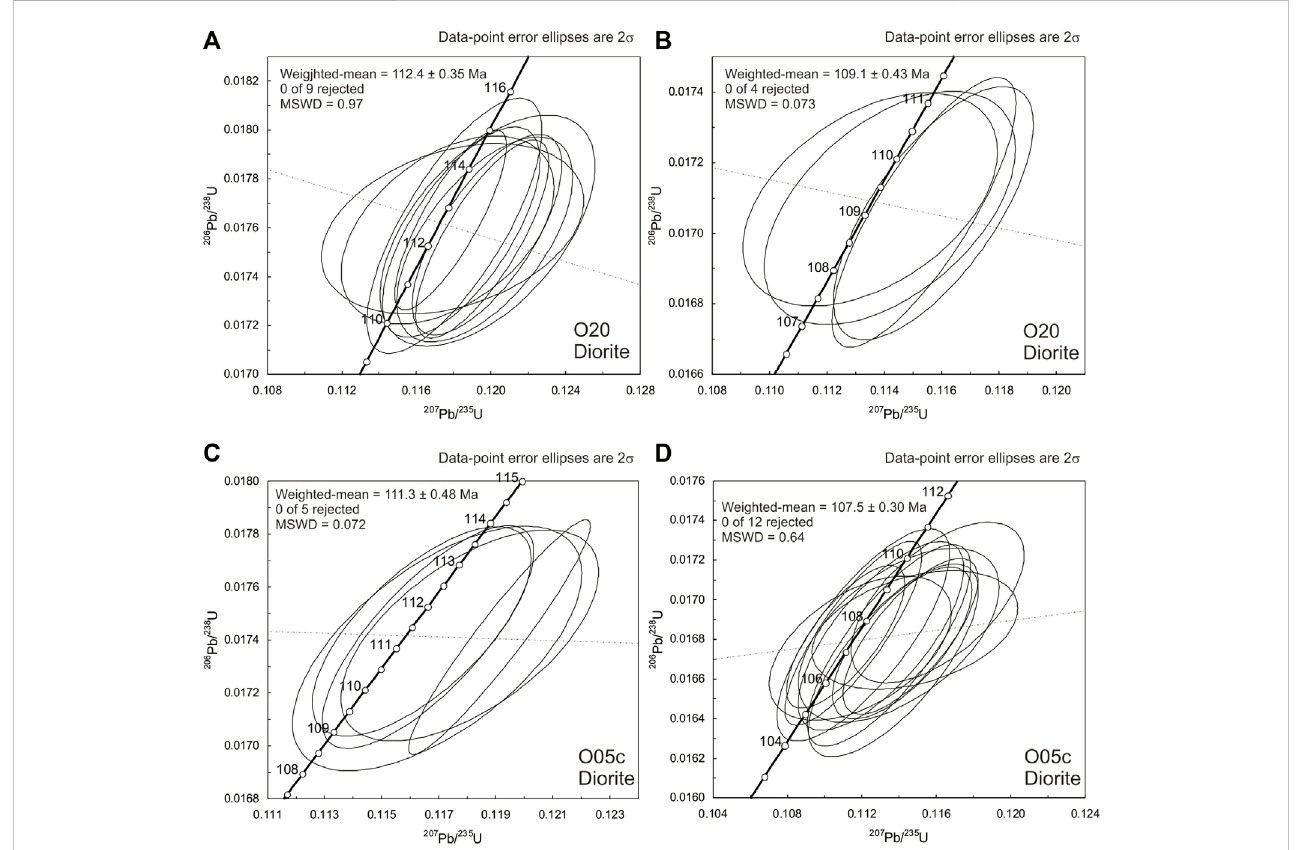
FIGURE 5 (A) Concordia diagram with the weighted-mean age of the older (inherited) population of zircon U-Pb data from sample O20. (B) Concordia diagram withtheweighted-meanageoftheyoungerpopulation(emplacementage)ofzirconU-PbdatafromsampleO20. (C) Concordiadiagramwiththeweighted- mean age of the older (inherited) population of zircon U-Pb data from sample O05c. (D) Concordia diagram with the weighted-mean age of the younger (emplacement age) population of zircon U-Pb data from sample